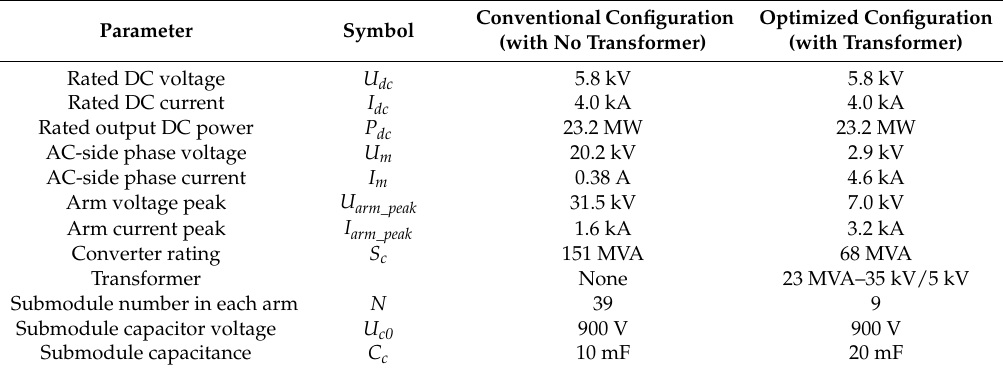
Table 1. Electrical parameter comparison of the MMC-DDI under conventional configuration and optimized configuration.